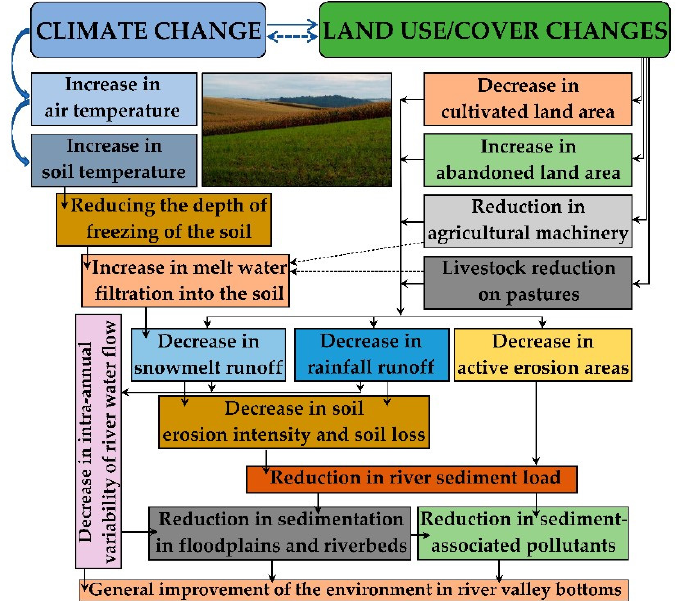
Figure 12. Generalized scheme for explaining the combined effects of climate and land-cover/-use changes on the temporal dynamics of hydrological and erosion/sedimentation processes in river basins of the most populated and agriculturally developed part of European Russia during the last few decades.